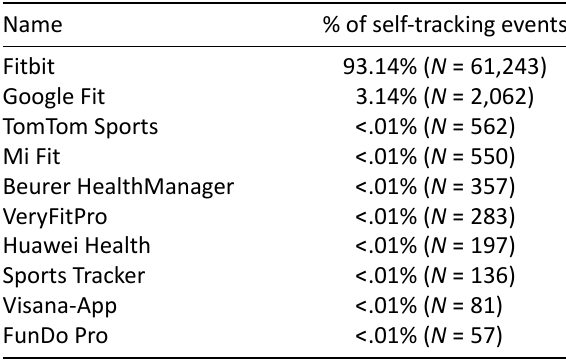
Table 1. Most used self‐tracking applications in Switzerland (based on tracking